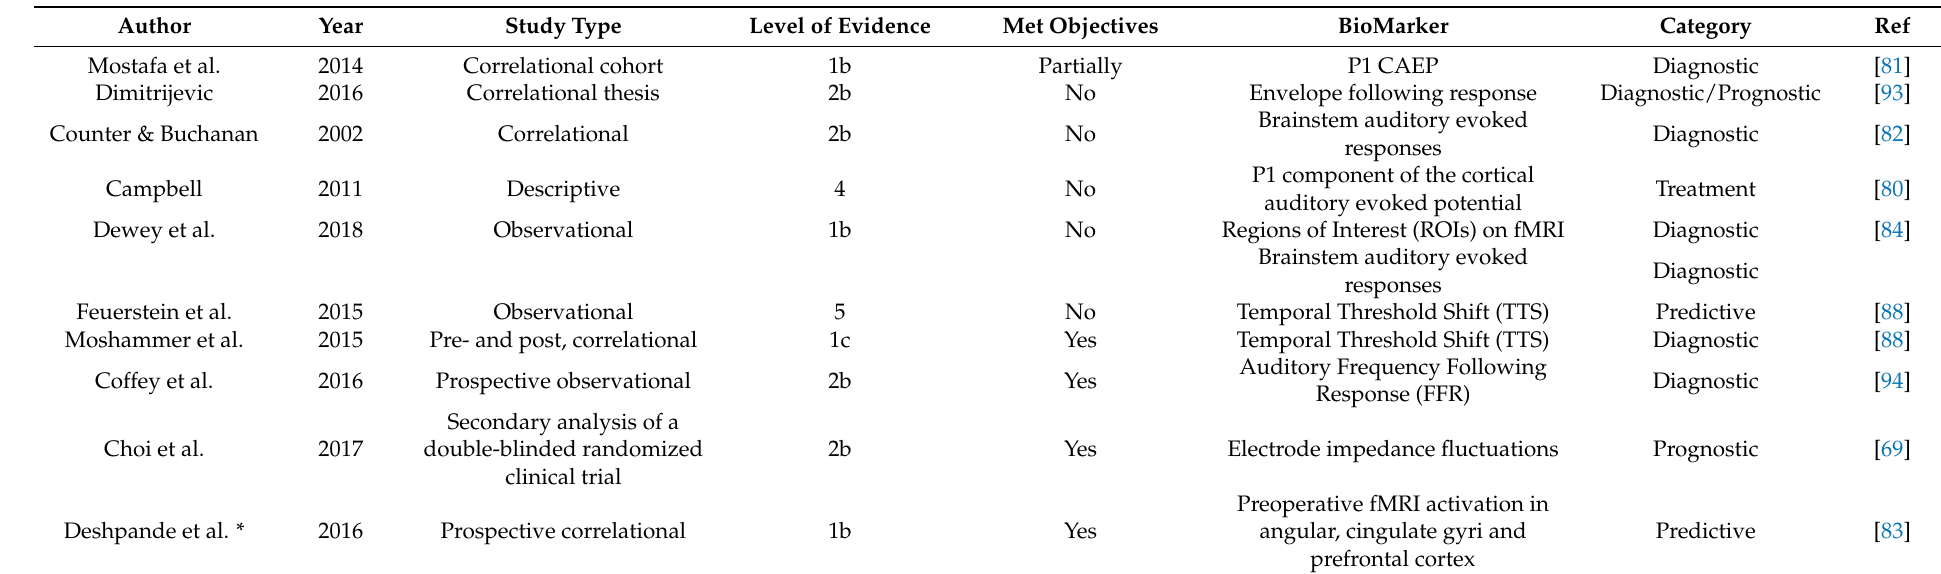
Table 2. Functional biomarkers related to the inner ear in